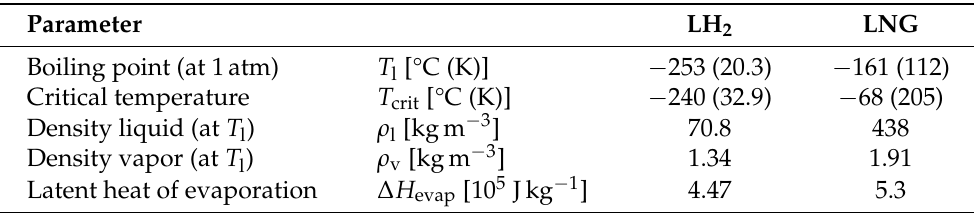
Table 2. Properties of LH 2 and LNG relevant for spill and RPT. The properties are calculated using the EoSs specified in the text (density error <